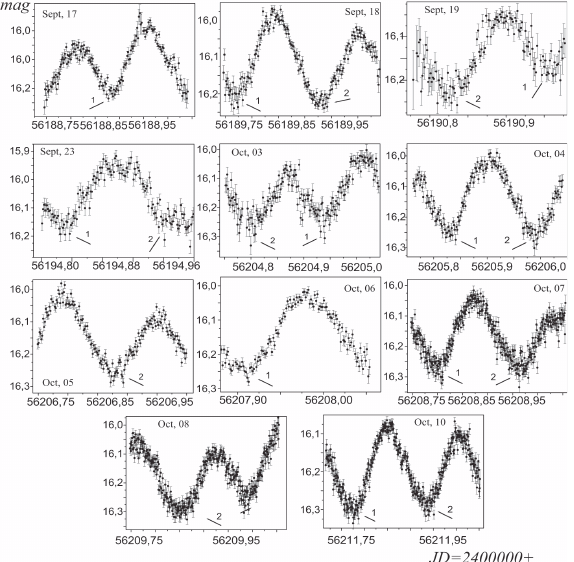
Figure 5: The AAVSO LCs obtained in September and October 2012. The primary and secondary mini- mum are marked by 1 and 2, respectively.